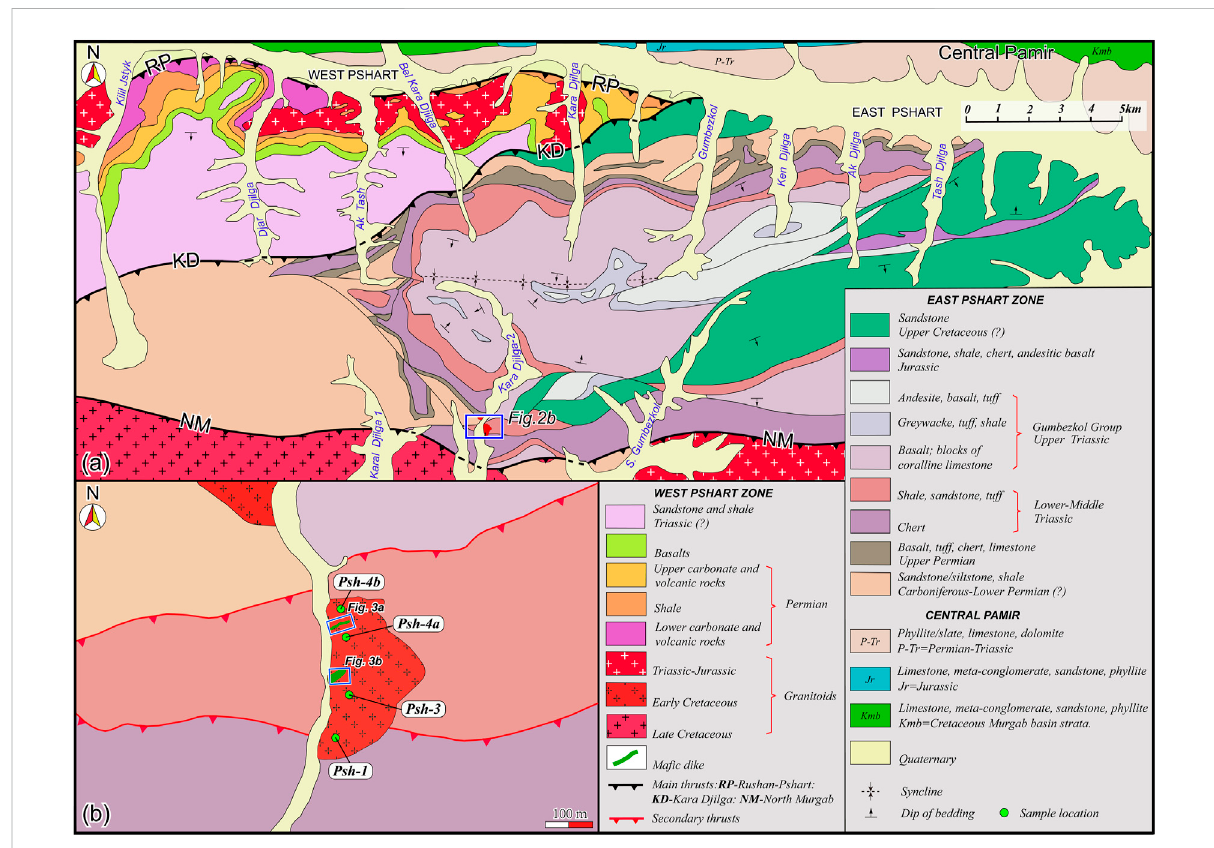
FIGURE 2 (A) Geological map of the Pshart zones showing the Kara Djilga fault, which is the boundary between the East and West Pshart zone. (B) Investigation area. The location of (B) is shown in (A) (red square). The map was modi fi ed after Leven